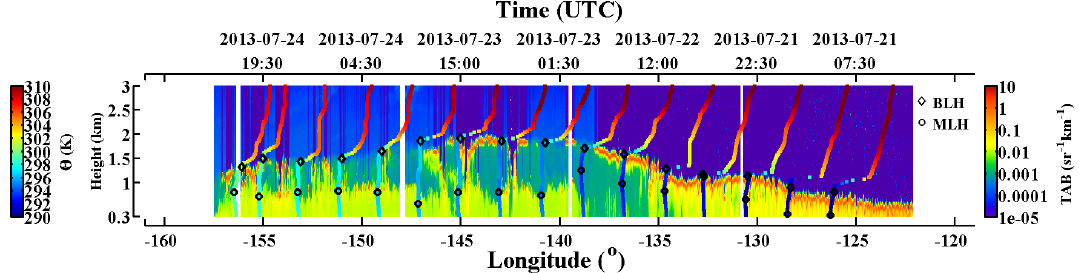
Figure 1. Potential temperature profiles and retrieved MBL structure (black diamonds for BLH and black circles for MLH) for a MAGIC leg from 21 to 24 September 2013, overlaid with total attenuated backscattering from HSRL.